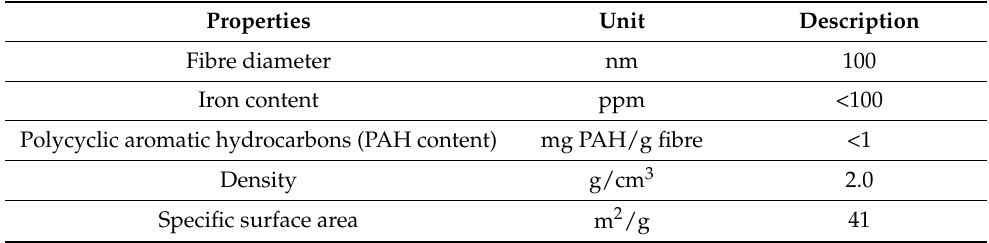
Table 1. Physical and chemical properties of